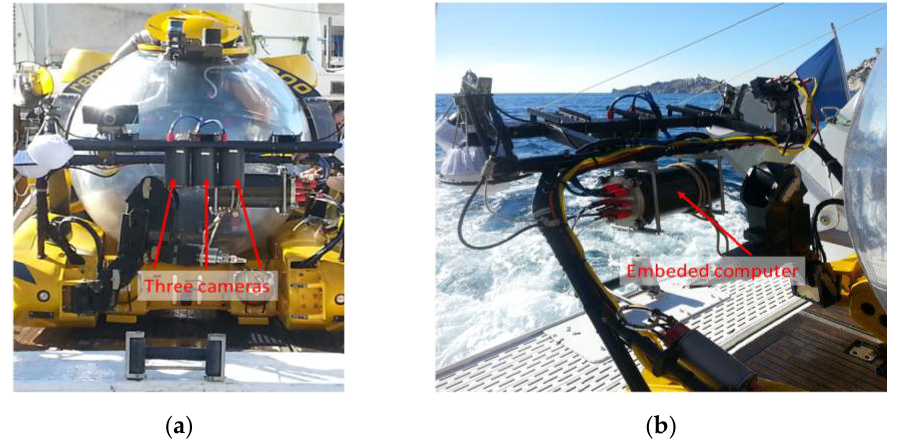
Figure 6. Images of the configuration used installed on the submarine; the technical bar of the Rémora 2000, the three cameras in their vertical cylindrical housing; ( a ) front view; ( b ) back view showing the embedded computer.